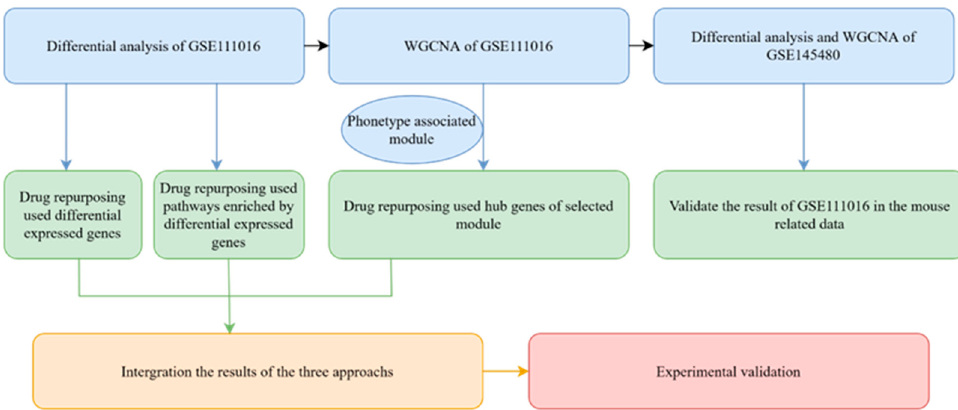
Figure 1. Flow diagram of the drug repurposing analysis. Step 1: Differential analysis, ranked gene set enrichment analysis, and WGCNA of GSE111016 and GSE145480. Step 2: Three different algorithms were used to perform drug repurposing, respectively, based on the differentially expressed genes, significant enrichment pathways, and hub genes of the co-expression module. Step 3: CRank algorithm was used to integrate the results of the three different drug repurposing algorithms. Step 4: Top-ranked vorinostat was selected for experimental validation in vitro.